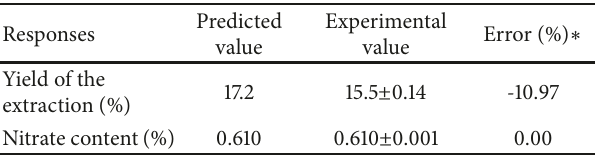
Table 3: Predicted values, experimental values, and percenterror of the